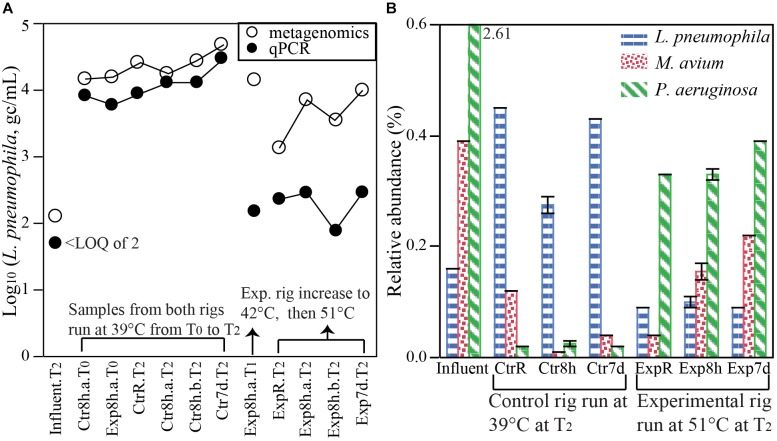
Quantification of OPs DNA sequences in hot water samples. (A) Comparing the numbers of L. pneumophila in water samples (gc/mL) quantified by metagenomics [relative abundance (%) of L. pneumophila (i.e., counts of reads identified as L. pneumophila / total read counts) × 16S rRNA gene counts from qPCR quantification (gc/mL)] with L. pneumophila numbers from direct quantification by qPCR targeting the mip gene. (B) Relative abundances of L. pneumophila, M. avium, and P. aeruginosa (i.e., counts of reads identified as the bacteria species / total read counts in a sample, %) derived from metagenomic analysis. Distinct responses to temperature setting and stagnation are apparent for the three pathogens. LOQ: limit of quantification. Error bars in panel B represent standard deviations of two biological replicates.